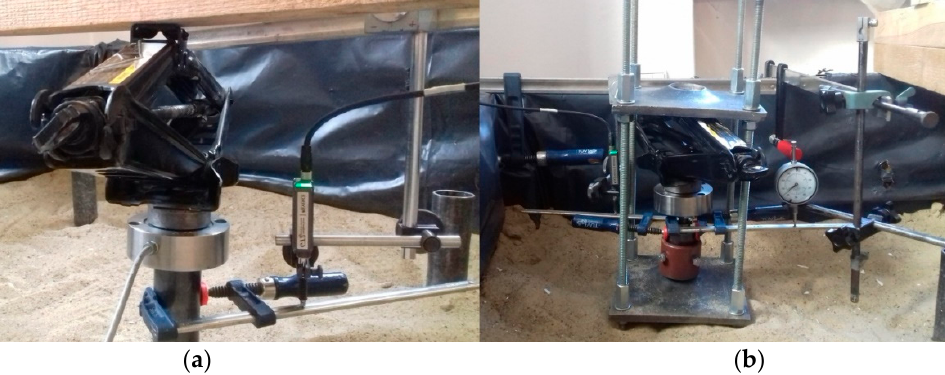
Figure 8. Stands for traditional static load tests ( a ) and bi-directional tests ( b ).